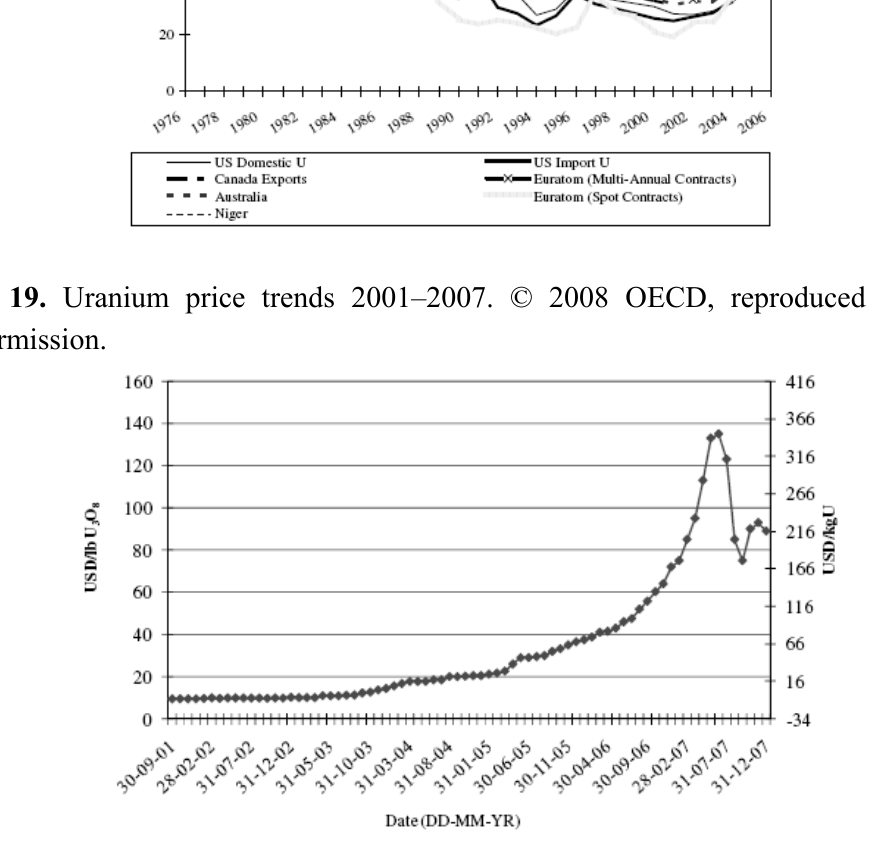
Figure 20. Trends in uranium exploration expenditure. 2007 figures are estimates. © 2008 OECD, reproduced from [96] with